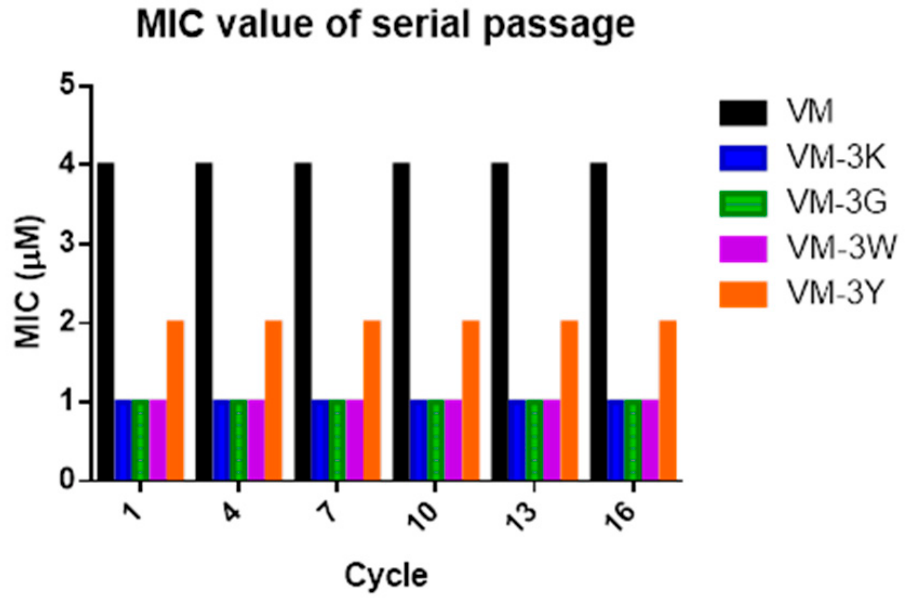
Figure 6. Assessment of the drug-resistance induction of VM and modified peptides in S. aureus after 16 passages. The X -axis represents the cycles of passage, and the Y -axis represents the MIC value of each peptide/analogue used.